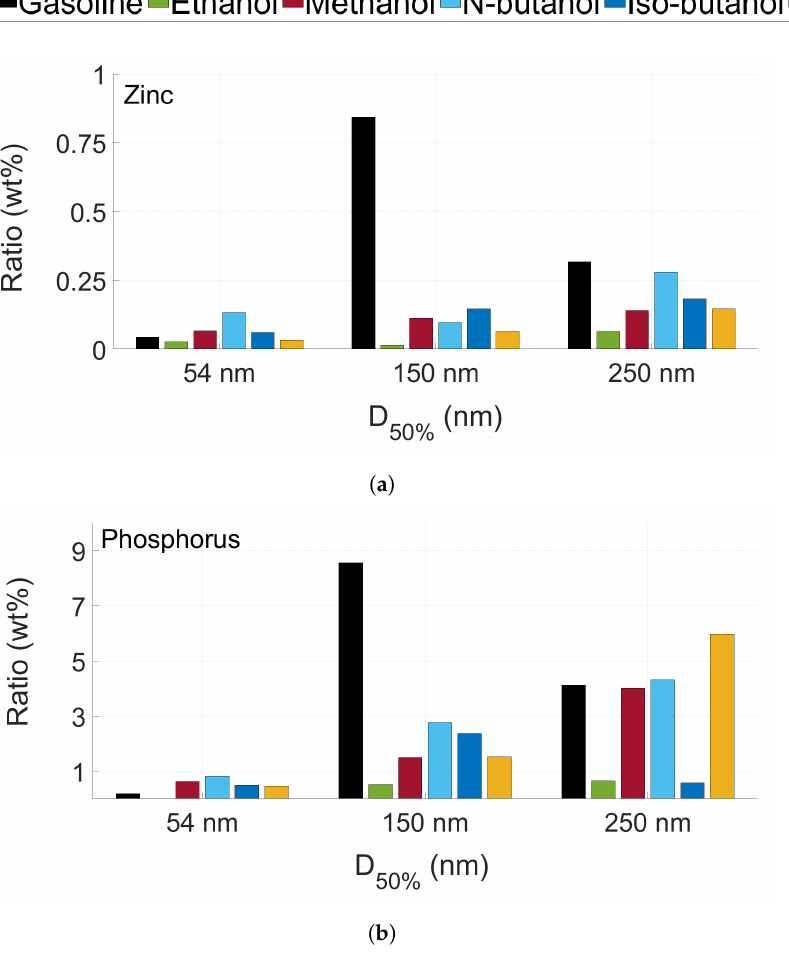
Figure 10. Elemental composition of the particles from the HT-ELPI+ filters: ( a ) zinc and ( b )